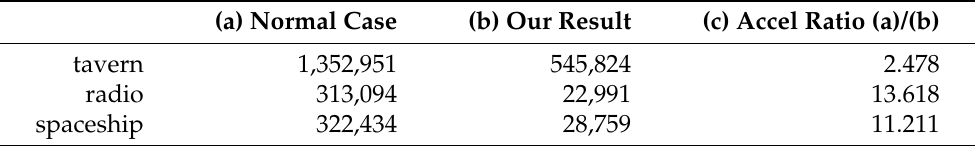
Table 2. Performance of our rendering results (unit: µ sec).